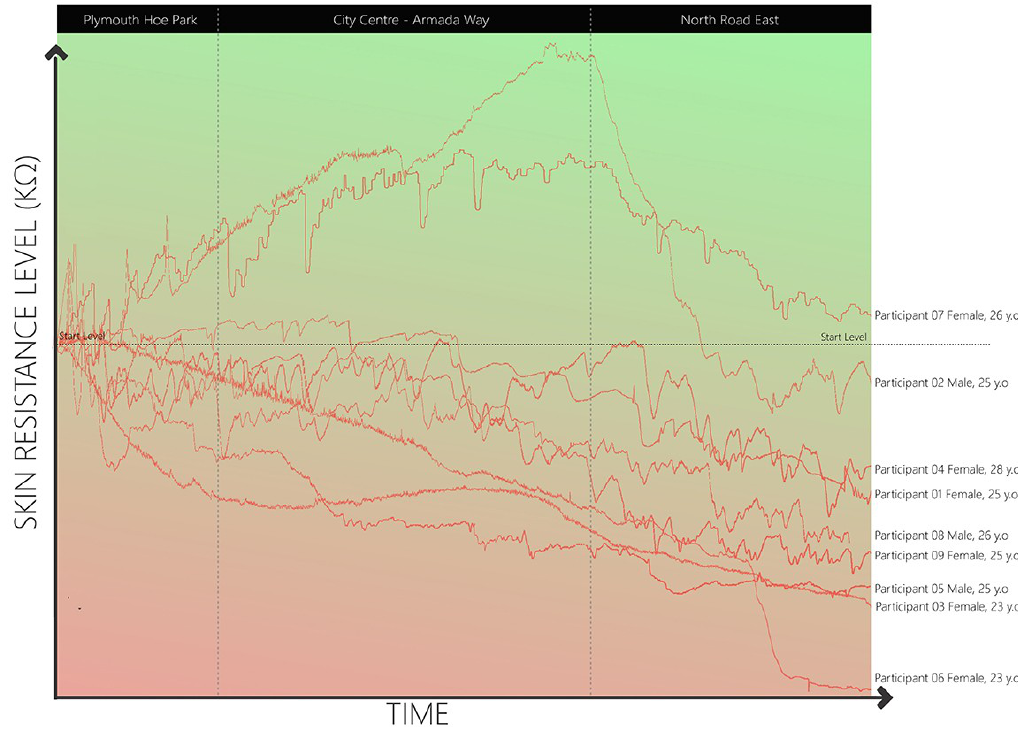
Figure 8. Results—Combined results of all participants showing a general trend of a higher skin resistance level at the start of the walk and lower skin resistance at the end.